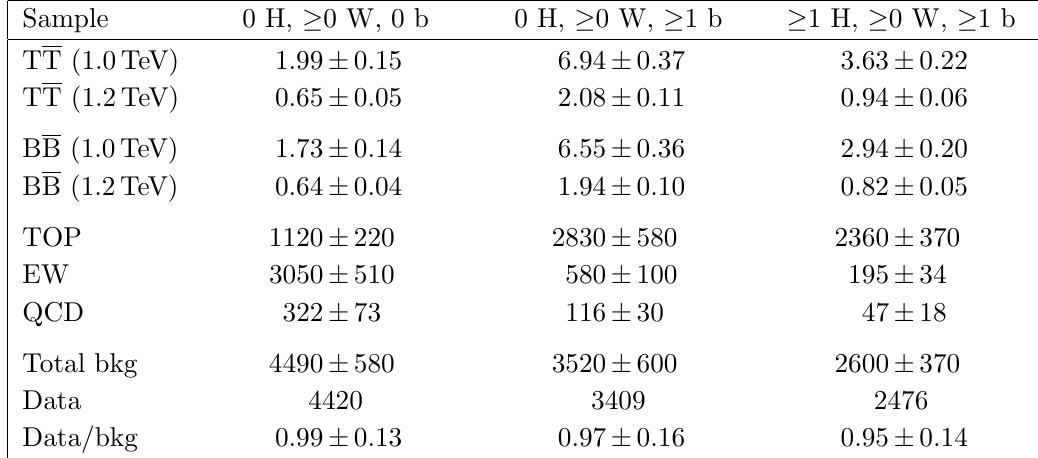
Table 2 . Predicted and observed event yields in the aggregated control region categories of the single-lepton channel. Uncertainties include both statistical and systematic